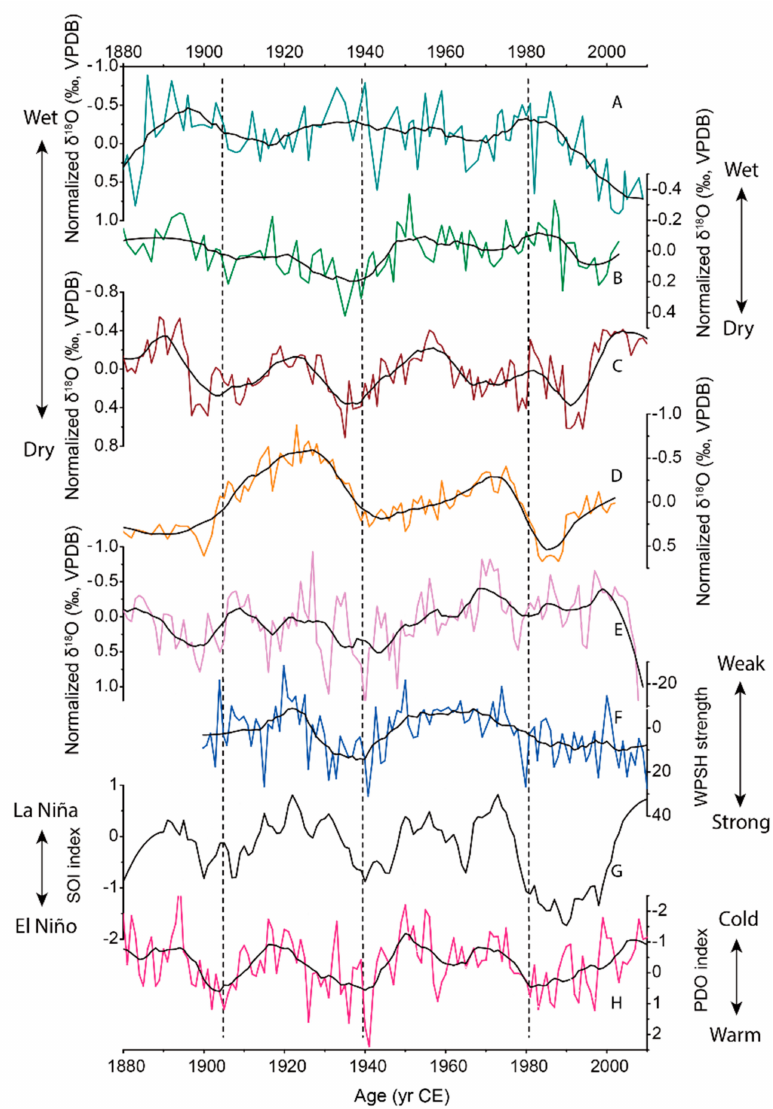
Figure 10. Normalized speleothem δ 18 O records during the last 200 yrs and reconstructions of WPSH, ENSO and PDO variability. ( A ) Huangye [54], ( B ) Wanxiang [10], ( C ) Shihua [118], ( K ) Heshang [51] and ( E ) E’mei [44] cave δ 18 O records in China. ( F ) WPSH strength (data from China National Climate Center); ( G ) Southern Oscillation Index (SOI, data from National Center for Atmospheric); ( H ) PDO index (data from Joint Institute for the Study of the Atmosphere and Ocean). The black lines in each panel are the 20 year running